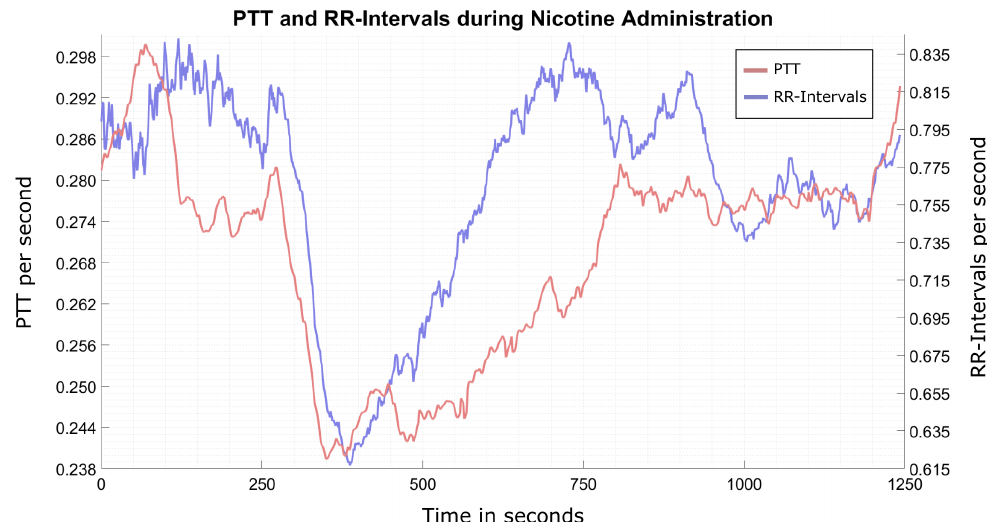
Figure 11. Effects of nicotine on the PTT. The data set recorded with SPECTRE 3.0 shows the PTT and R-to-R interval (heart rate) progression over time. Nicotine intake starts at 300s and ends at approximately